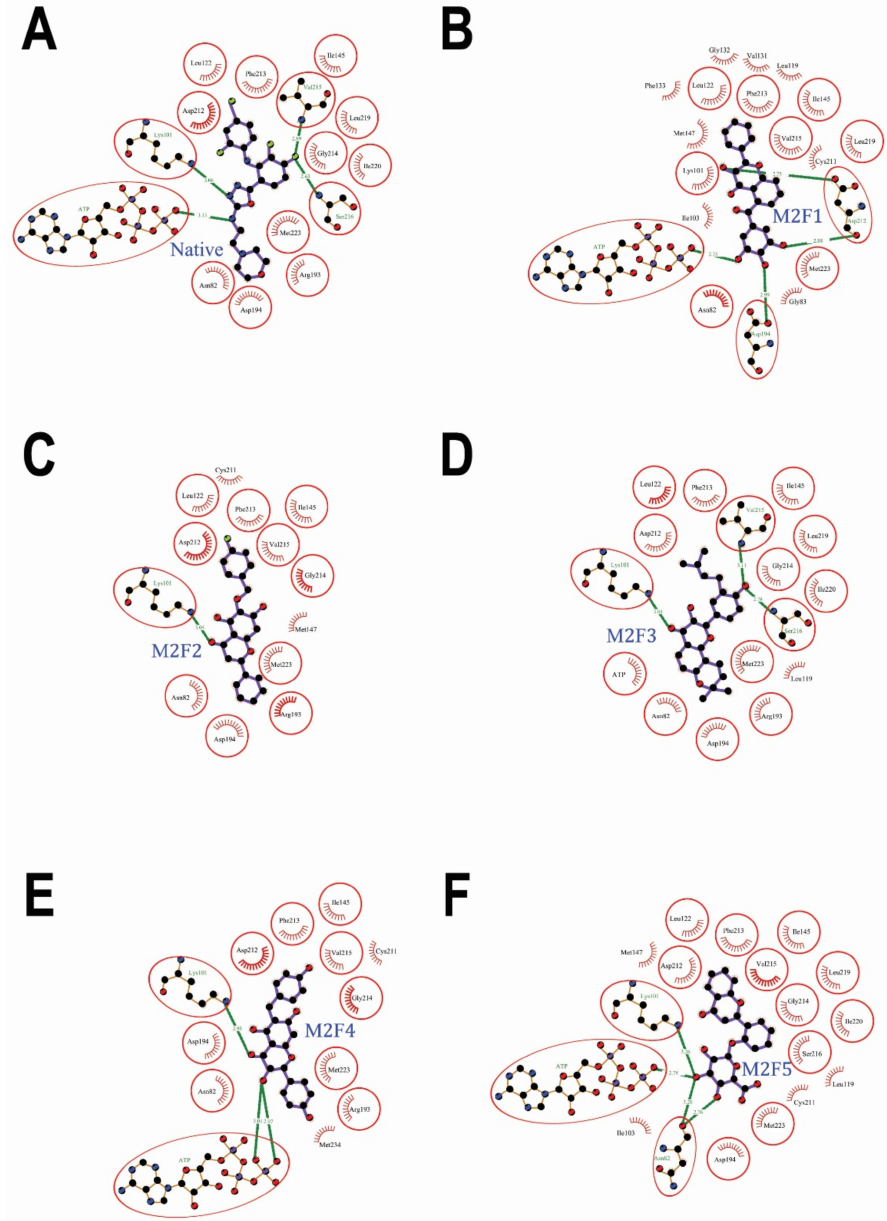
Figure 4. MEK2 protein–ligand interaction plots 1. Native inhibitor ( A ) and selected flavonoids ( B – F ). The residues forming non-bonding interactions are shown as red bristles, while residues forming hydrogen bonds and the bound ligand are shown as ball-and-stick representations. The carbon atoms are shown as black balls, nitrogen atoms as blue balls, oxygen atoms as red balls, and sulfur atoms as yellow balls. The interacting residues in common with the native inhibitor are shown in circles. The hydrogen bonds are shown as green dashed lines labeled with bond length (in